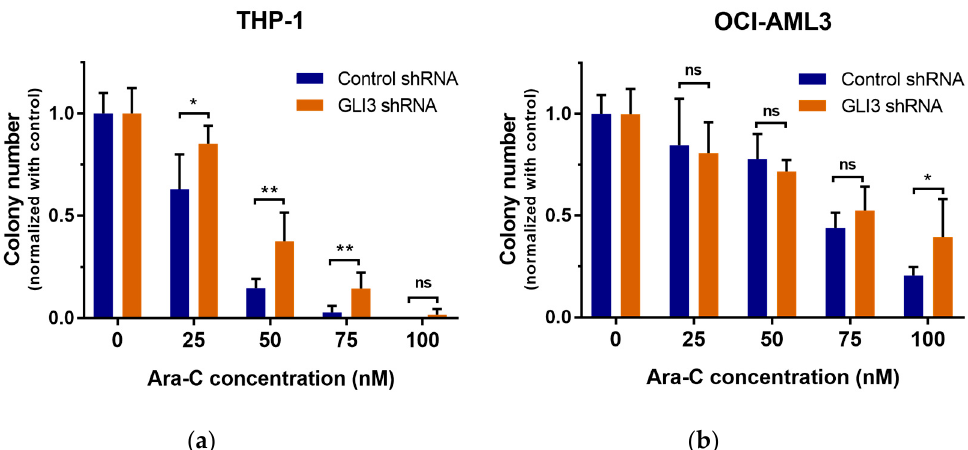
Figure 4. GLI3 knockdown partially protects AML cells against the cytotoxic e ff ect of Ara-C. AML cell lines THP-1 ( a ) and OCI-AML3 ( b ) after GLI3 knockdown and treatment with scrambled shRNA control were subjected to di ff erent Ara-C concentrations for 7 days. Colony numbers were counted and normalized to those of the untreated controls. The average number of colonies (Ø) in the untreated control samples was 84 (scrambled shRNA) and 62 (GLI3 shRNA) for THP-1 and 72 (scrambled shRNA) and 83 (GLI3 shRNA) for OCI-AML3; * p < 0.05 and ** p < 0.01 in Welch’s t -test; ns, statistically not significant.